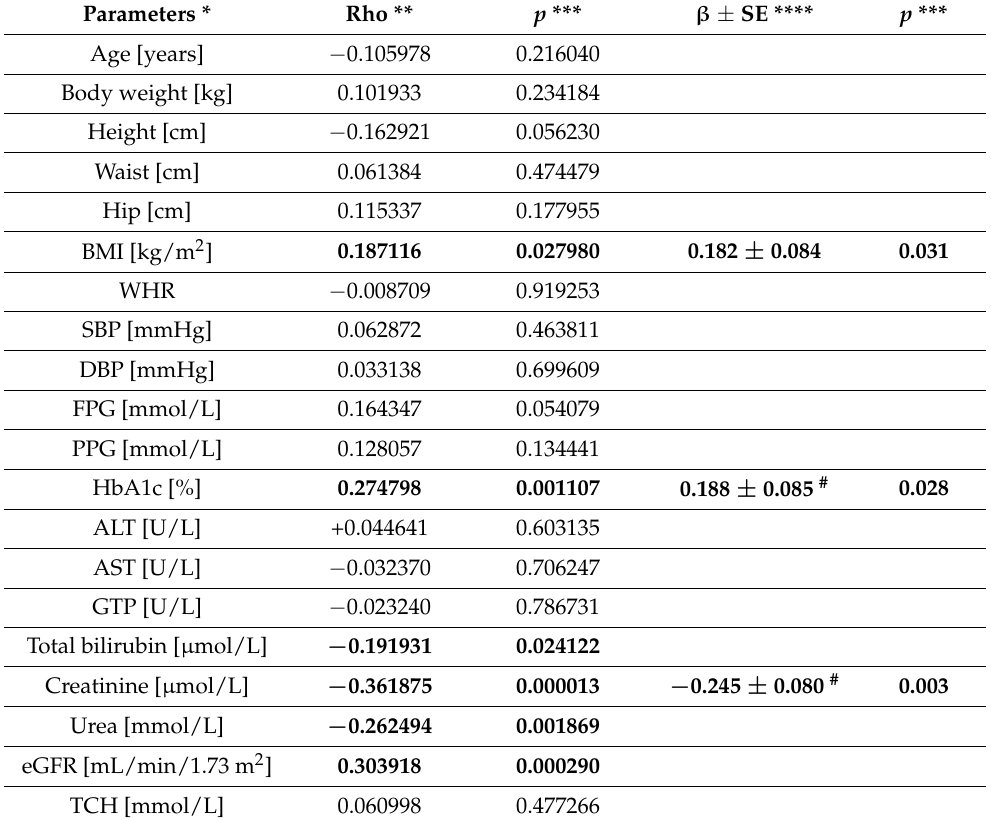
Table 3. Spearman correlations and linear regression analysis of irisin concentration and anthropo- metric and biochemical parameters in the whole study population ( n = 138). Only the best irisin- associated variables are shown, as assessed by the stepwise forward multiple regression method.